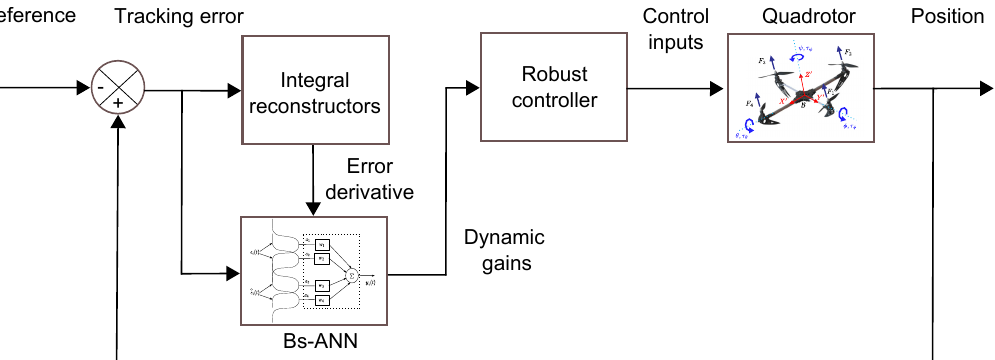
Figure 3. General structure of the adaptive robust motion control scheme.